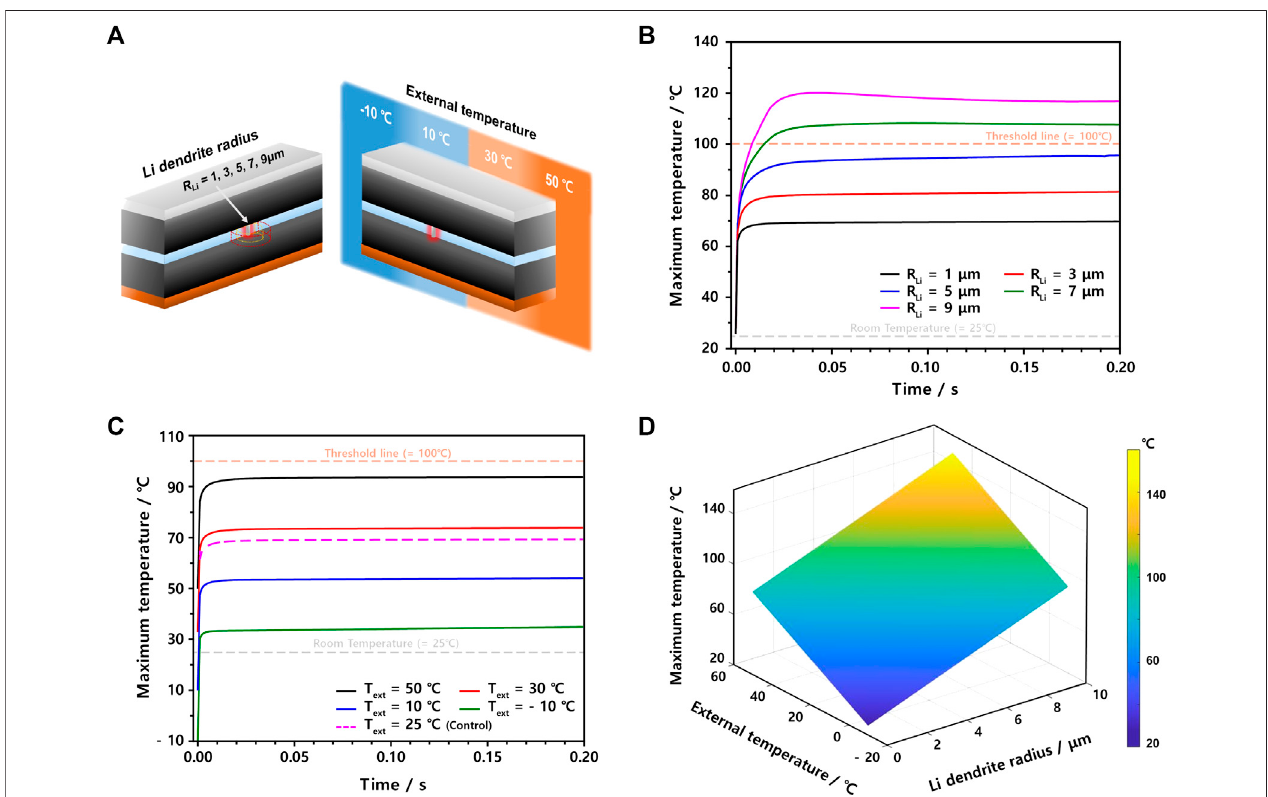
FIGURE3|(A) SchemetochangetheLidendrite radius (left)andexternaltemperature (right)inthisISC model.Themaximumtemperaturepro fi lesafter ISCoccur when (B) the Li dendrite radius changes from 1 to 9 μ m at 25 ° C and (C) external temperature changes from − 10 to 50 ° C (R Li = 1 μ m). (D) 3D map showing maximum temperatures as both Li dendrite radius and external temperature